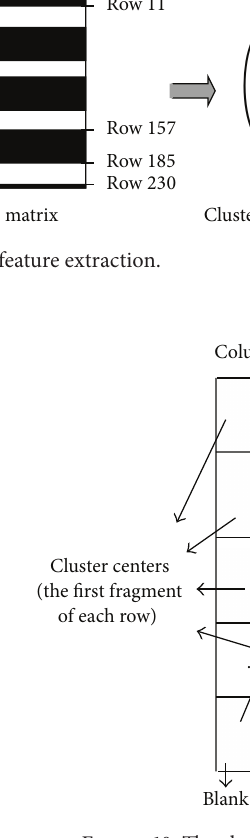
Figure 10: The cluster center of all the